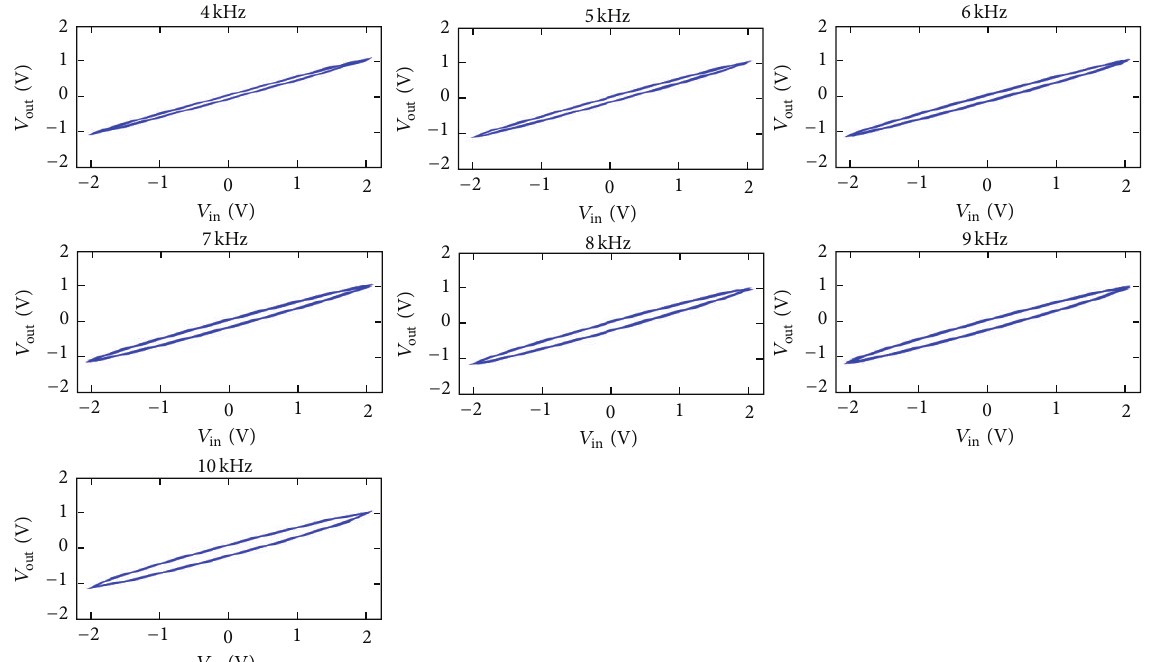
Figure 8: Lissajous curves on measured input ( V in ) and output ( V out ) voltages in the frequency range between 4kHz and 10kHz for the device IPMC AbsT- 5 h